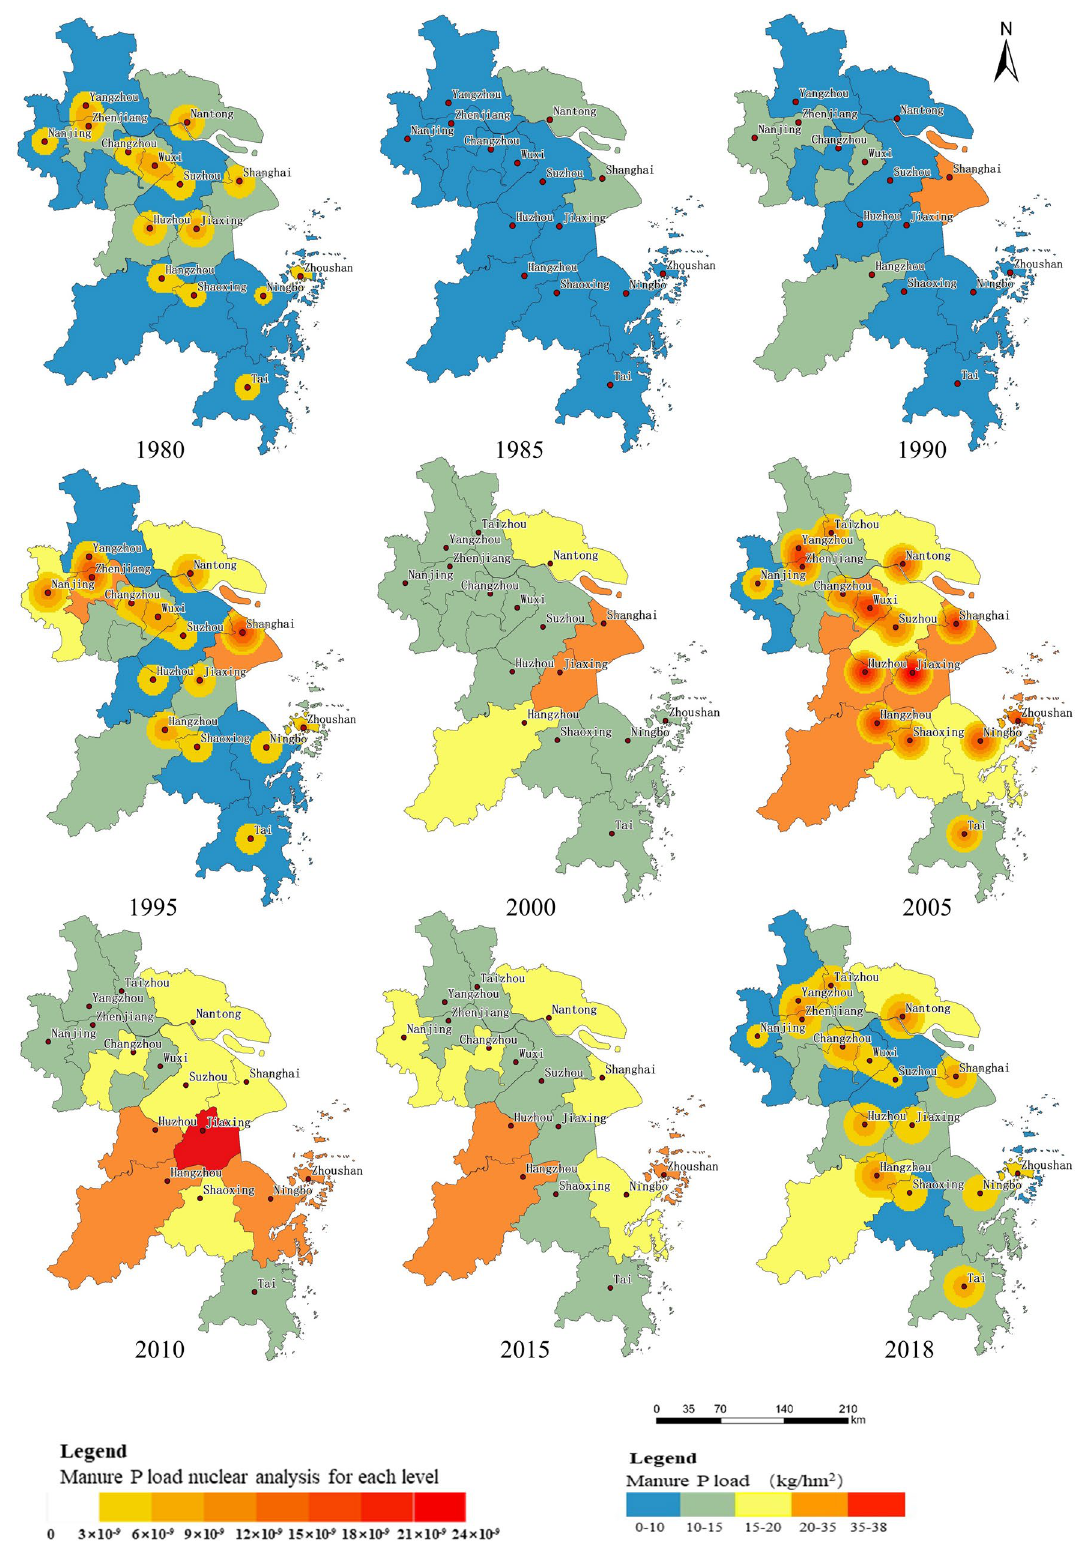
Figure 5. Spatiotemporal distribution of manure P load in the Yangtze River Delta from 1980 to